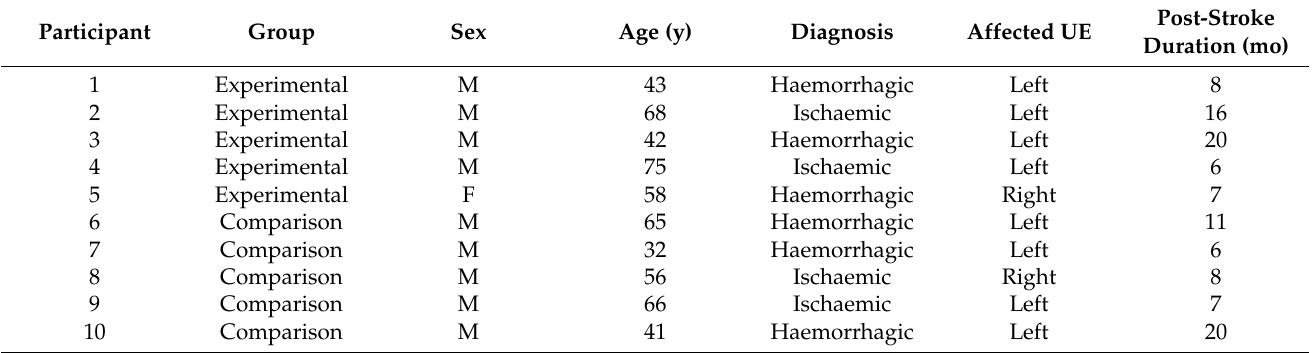
Table 1. Demographic characteristics of the participants (n =